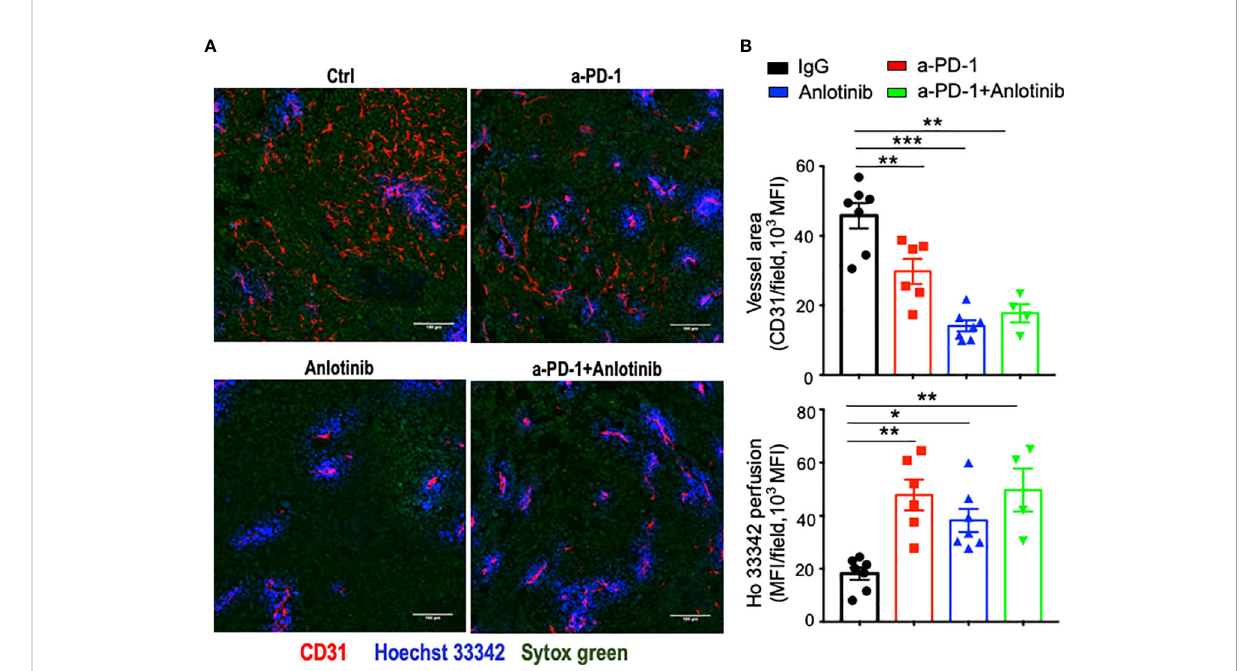
FIGURE 5 Either anti-PD-1 therapy or its combination with effective low-dose Anlotinib induced tumor vascular normalization. EO771 breast tumor- bearing mice were prepared, Anlotinib treatments (2 mg/kg/daily), and anti-PD-1 therapy (5 mg/kg, every three days) were conducted as described in Figure 2. Treatment duration was one week. (A) Representative images of Ho33342 perfusion (blue) and CD31-staining (red). Scale bar = 100 µm. (B) Ho33342 perfused tumor areas and vessel density (CD31). The signi fi cance was determined by one-way ANOVA ( n = 4 – 7 mice per group). The data are presented as means±SEM. * p < 0.05; ** p < 0.01; *** p <